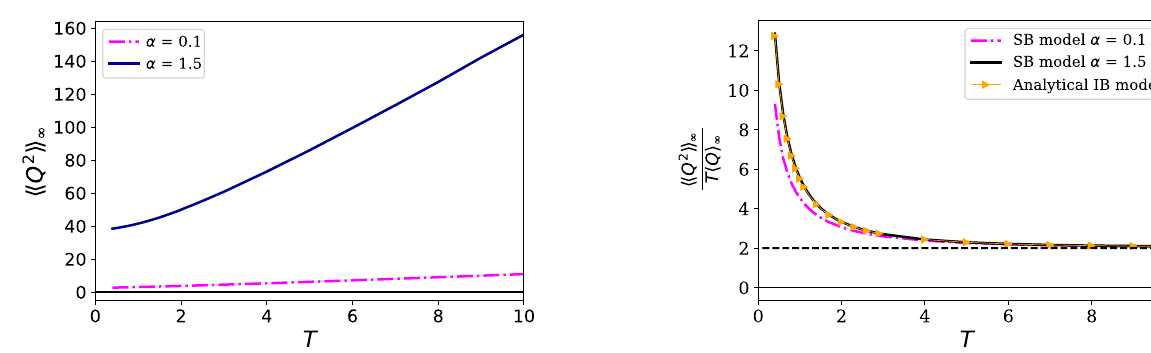
FIG. 8. Variance of the heat distribution as a function of tem- FIG. 9. Asymptotic ratio of the variance to the mean heat as perature in the spin-boson model for both weak ( α = 0.1) and a function of temperature, showing the validity of the FDR for strong ( α = 1.5) coupling starting from the initial state | ψ( 0 ) (cid:4) = T (cid:22) ω C . Dash-dot and solid lines are the numerical results for |↑(cid:4) . The parameters are ω = 5, K (cid:6) = 5, and (cid:6) = 0.01, with the spin-boson (SB) model for the values of α indicated. The C figure shows a comparison with the analytical solution for the p = 100 and u = 0.005 for α = 1.5, and p = 120 and u = 0.01 for α = 0.1. independent-boson model, which is independent of α (triangles). The FDR value of (cid:3)(cid:3) Q 2 (cid:4)(cid:4) ∞ / T (cid:3) Q (cid:4) ∞ = 2 is shown by the black dashed line. The parameters are the same as in Fig.